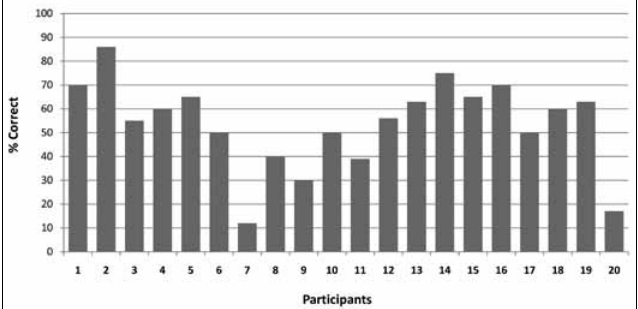
Fig. 4. Participants’ performance on the multiple instrument identification task (test 5, part 2).